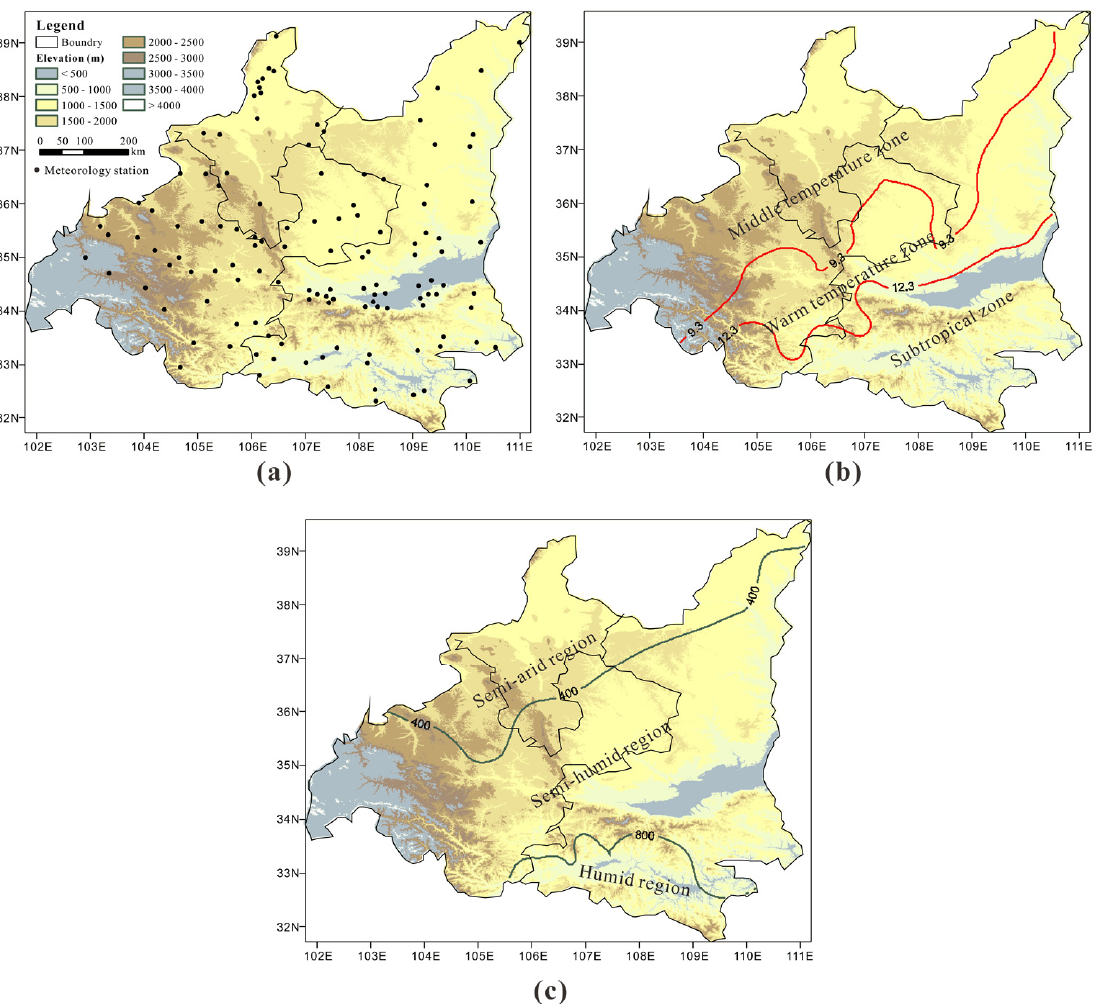
Figure 1. Overview of the study area: ( a ) digital elevation model and representative stations; ( b ) temperature zone division; ( c ) precipitation zone division.